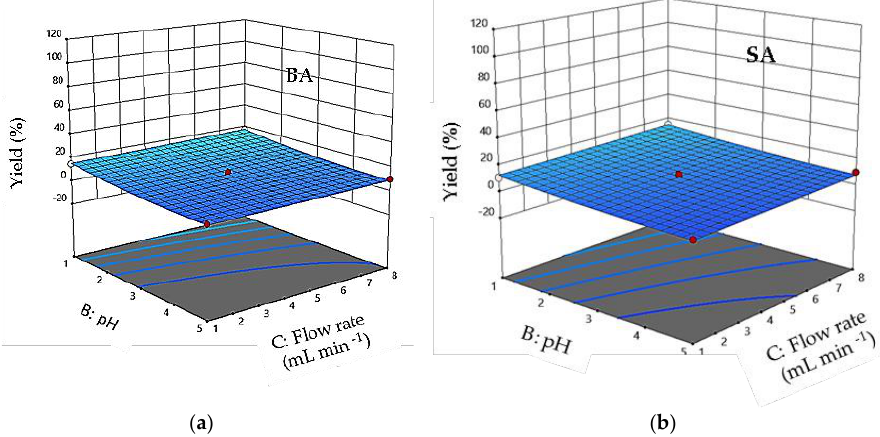
Figure 4. Response surface plots showing the effect of the sample volume and flow rate on percolation efficiency: pH = 1. ( a ) R rBA and ( b ) R rSA .